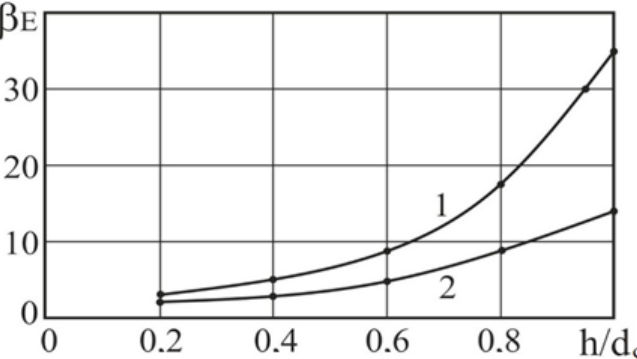
Figure 6. The dependence of the field enhancement on the cathode surface on the ratio of the protrusion’s height and the length of the cathodic potential drop region: 1- ratio a/b = 4; 2- ratio a/b = 2.